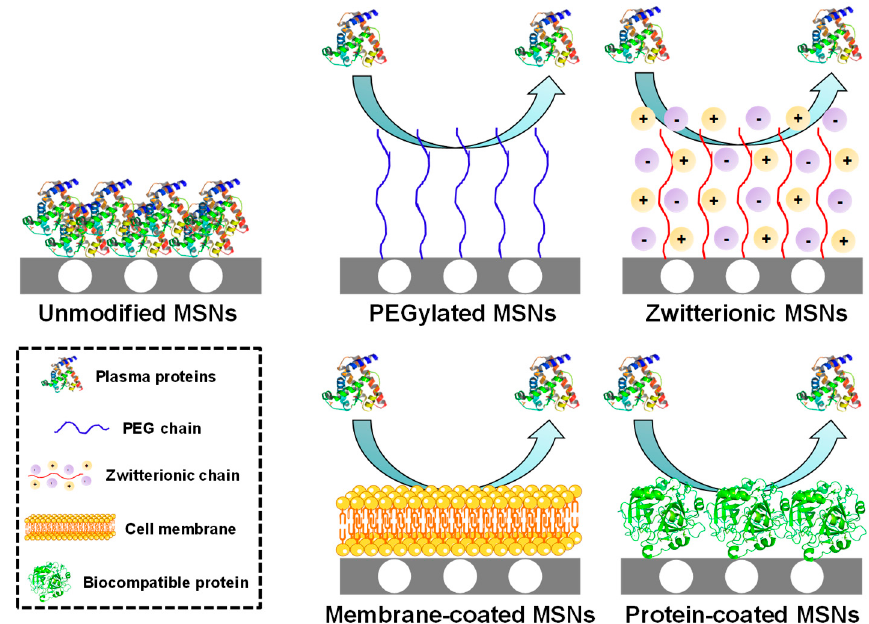
Figure 3. Schematic representation of the strategies employed to minimize protein adsorption and subsequent nanoparticle removal from the bloodstream. Unmodified MSNs tend to adsorb plasma protein, thereby triggering their clearance, whereas functionalized nanoparticles repel plasma protein and achieve longer circulation time.